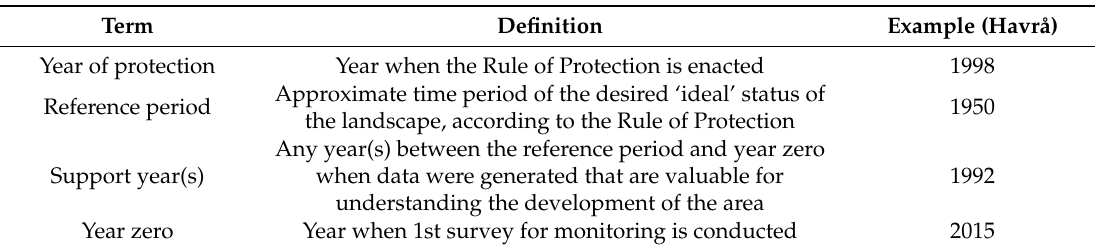
Table 2. Central terms for long-term monitoring of protected Cultural Heritage